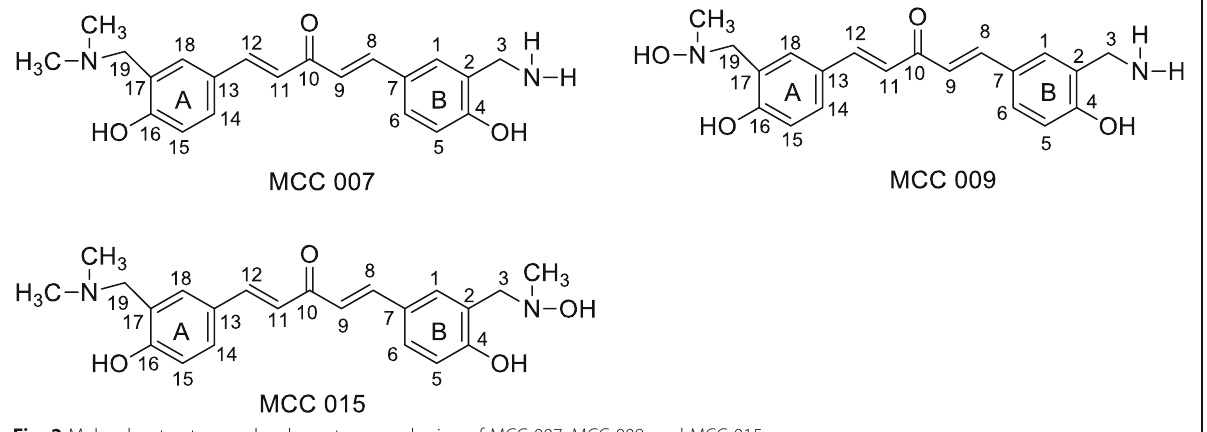
Fig. 2 Molecular structure and carbon atom numbering of MCC 007, MCC 009, and MCC